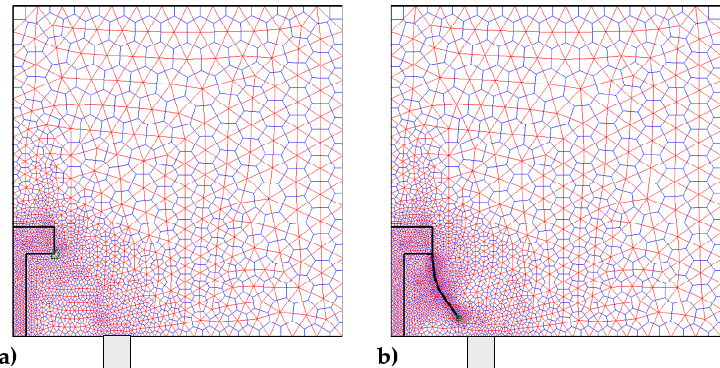
Figure 5. Shape of the domain modeled for the Lok-test simulation: ( a ) At the beginning of the computation and ( b ) after several steps of crack propagation.